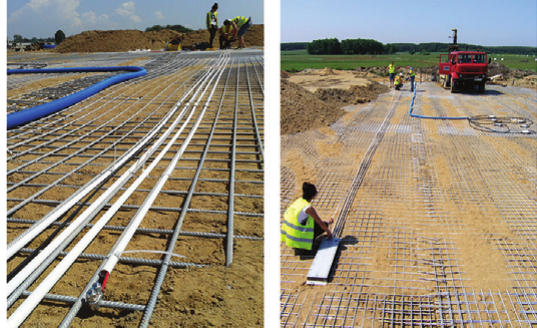
Fig. 7. Long base extensometers for measuring elongation of the steel